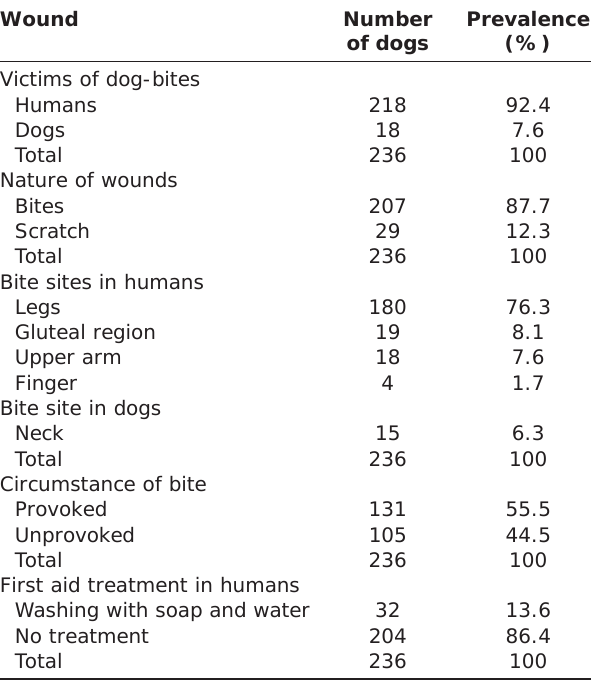
Table-3: History of the wound and treatment.